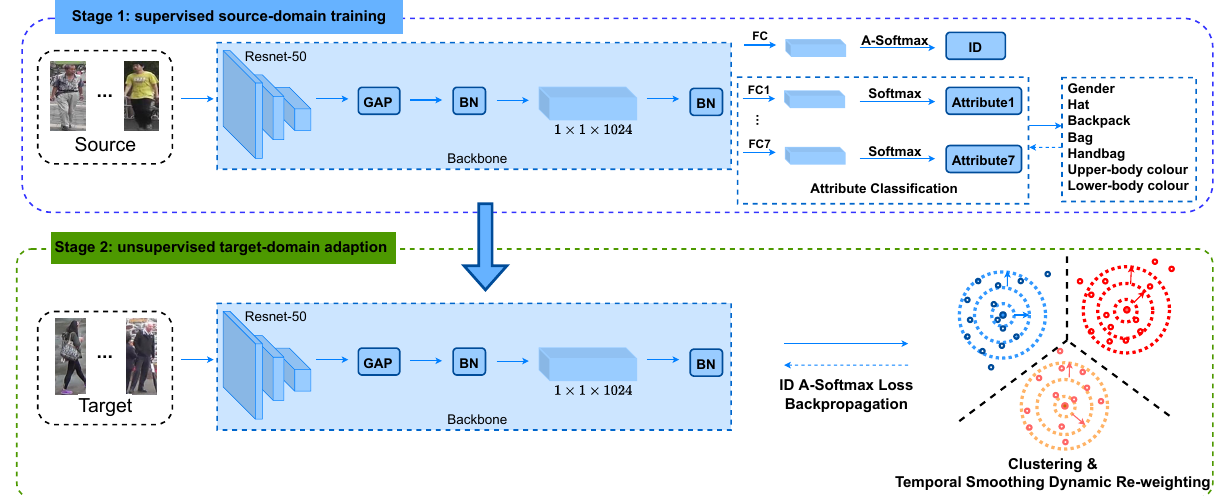
Figure 3. The framework of the proposed temporal smoothing dynamic re-weighting and cross- camera learning (TSDRC) method: we firstly trained our source domain model with both identity classification and attribute classification. Seven attributes, including gender, hat, backpack, bag, handbag, upper-body clothing color and lower body clothing color, were employed to enhance the source training of the source domain model. Then, we iteratively clustered the target-domain samples and dynamically re-weighted the informative samples in the target domain to fine-tune the source domain model. The circles with different colors represent different classes, and arrows indicate samples that belong to the same class close the distance, and samples that do not belong to the same class pull the distance. Here, GAP represents global average pooling, BN represents batch normalization, and FC represents fully